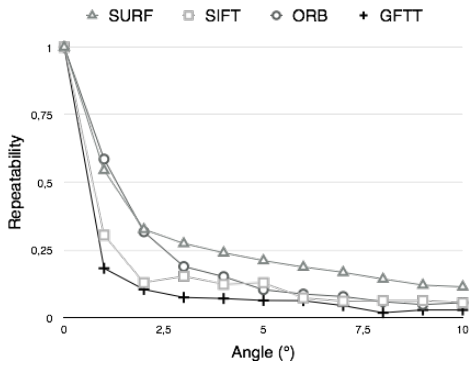
Figure 7: Repeatability of detector for several rota- tion angles